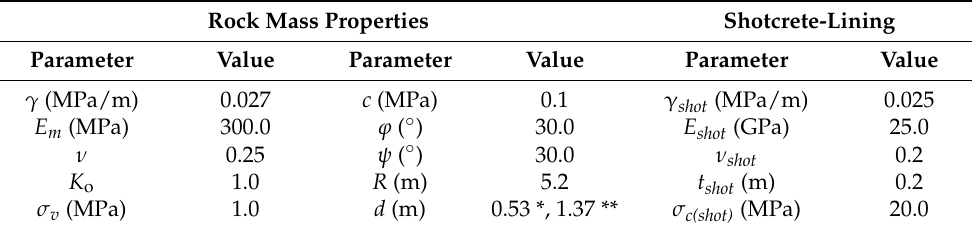
Table 1. Input data of the computation of DCM and FEM.